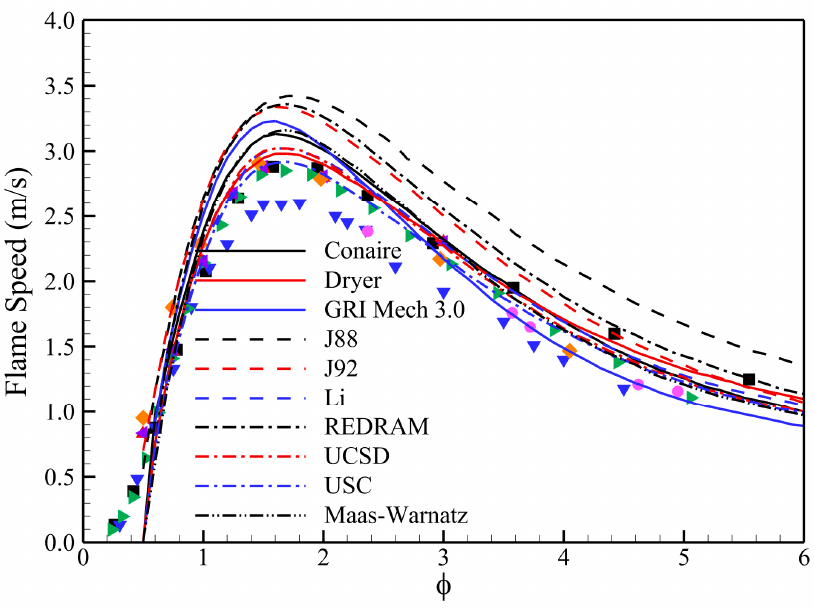
Figure 5. Laminar burning velocity calculated for initial temperature 298 K and 1 bar (symbols represent the experimental results from ReSpecTh repository).